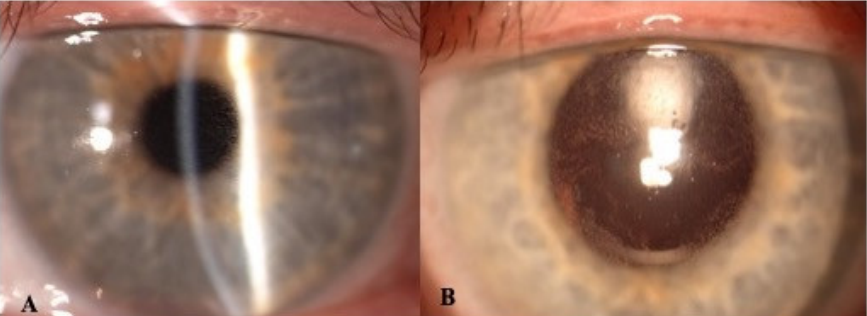
Figure 1. Slit-lamp photograph of the cornea in a patient with belamaf keratopathy. ( A ): Diffuse microcystic-like epithelial changes (MECs) in the central cornea. ( B ): Better visualization of MECs aided by retroillumination and pupil dilation.